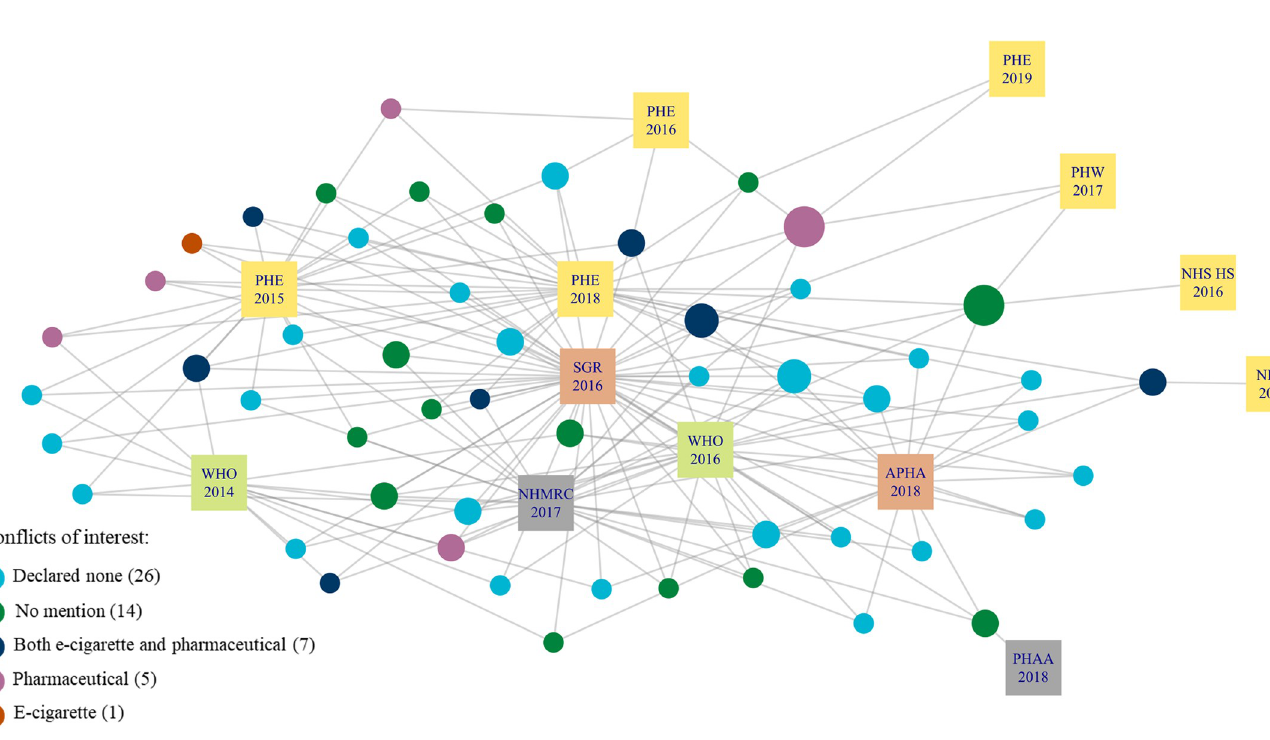
PLOS ONE | https://doi.org/10.1371/journal.pone.0255604 August 4,